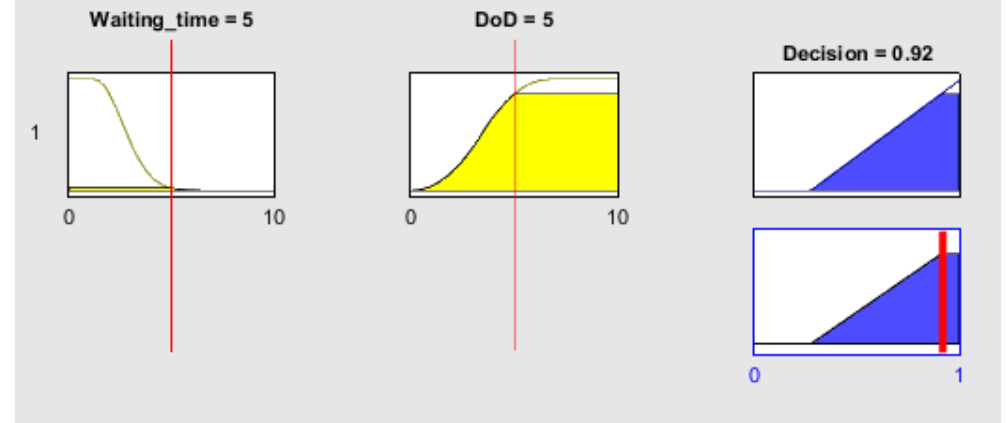
Figure 6. Membership functions and rule of fuzzy model for charge decision.